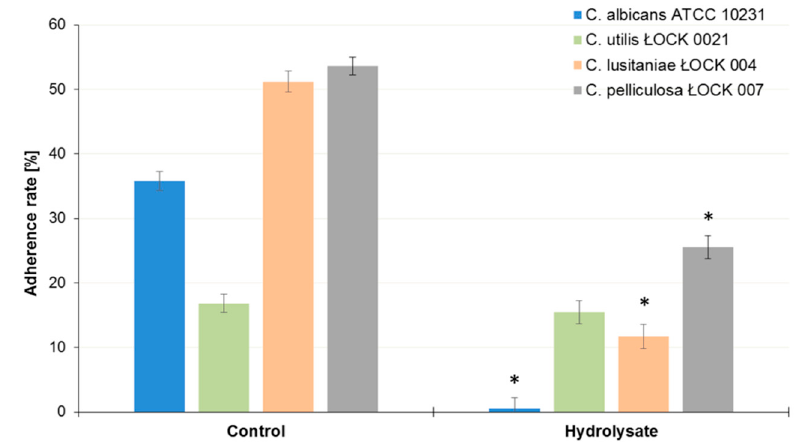
Figure 7. Adherence of Candida sp. yeast to Caco-2 cells in the presence SBP hydrolysate in comparison to the control samples. Error bars denote SD. The data represent means from three replicates in one experiment. * Results significantly differ from the relevant control, ANOVA ( p < 0.05).